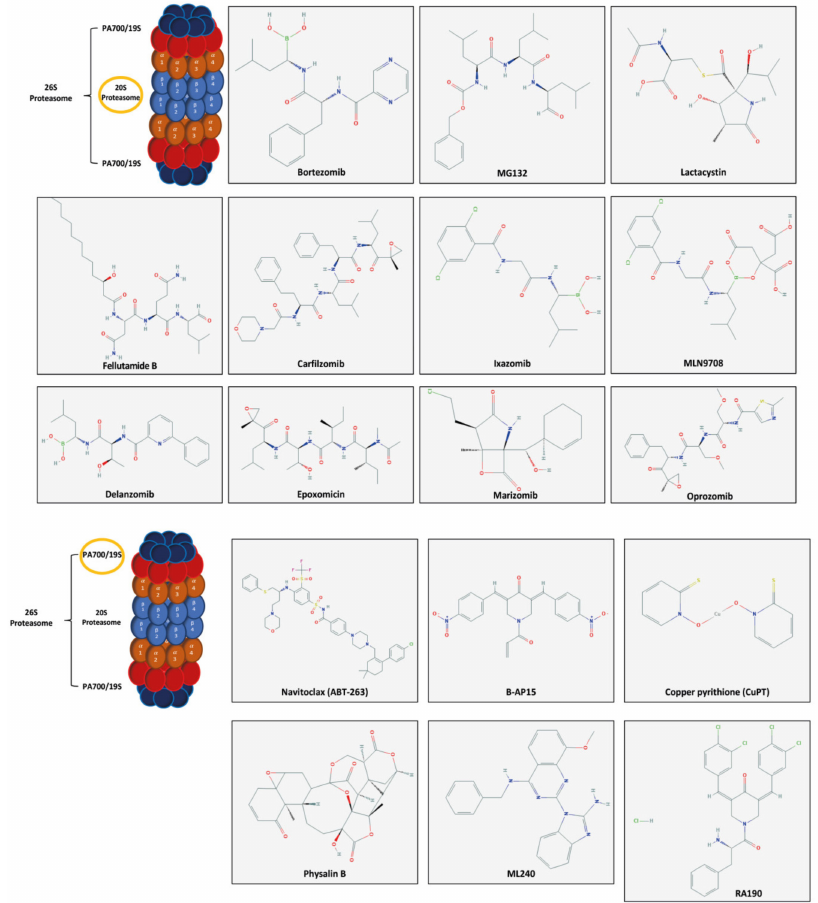
Figure 2. Chemical structures of several proteasome inhibitors. In yellow circle the subunit target of the drugs.